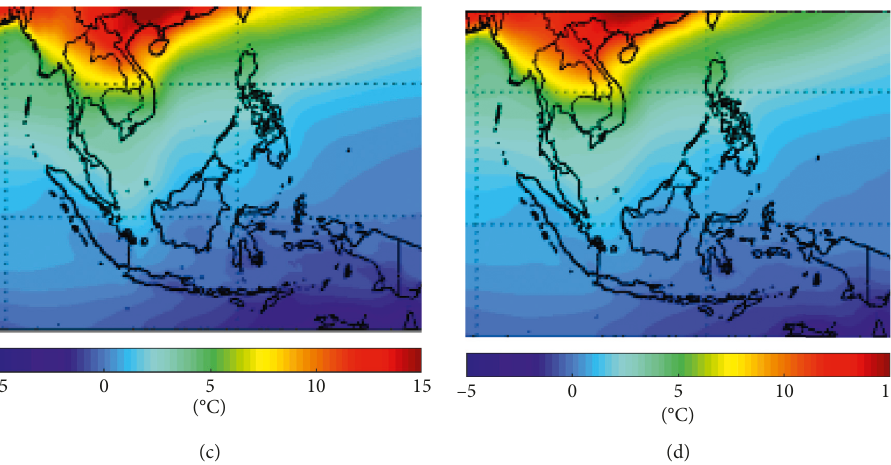
Figure 7: Comparisons of the mean seasonal cycle amplitudes of temperature (Season-Amp-Ts) for years 1960–1999 of (a) observations, (b) CNRM-CM5-2, (c) 6-GCM-Ensemble, and (d) 40-GCM-Ensemble.